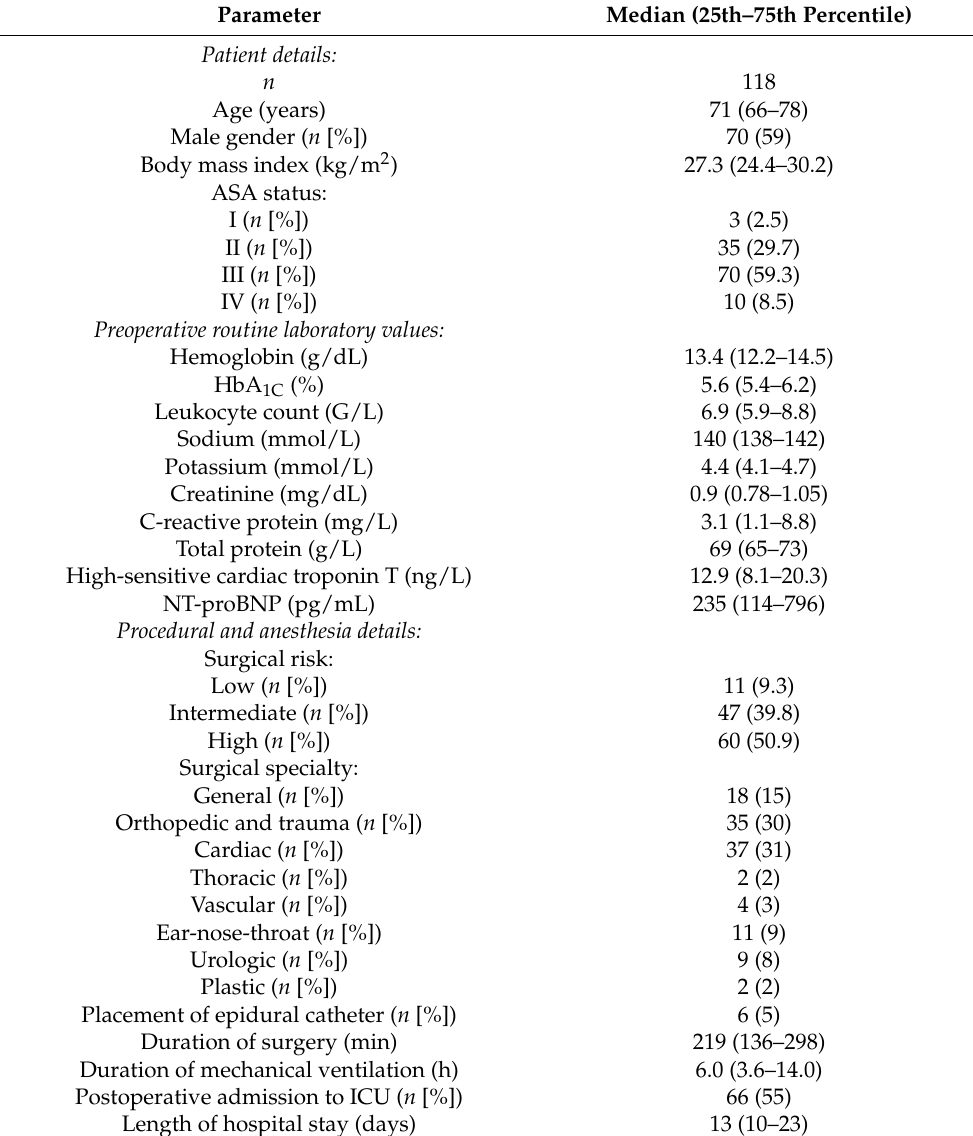
Table 1. Patient and procedural